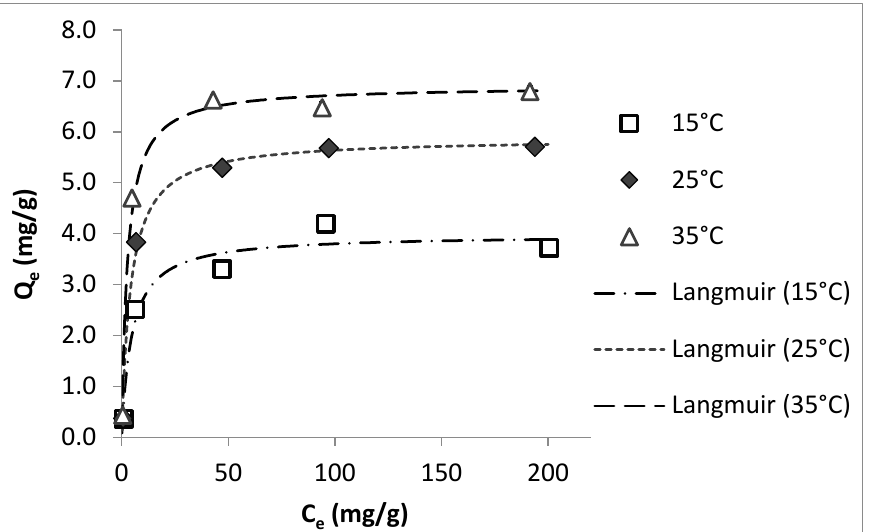
Figure 4. Effects of temperature on ciprofloxacin adsorption by colemanite (error bars are not shown for clarity).